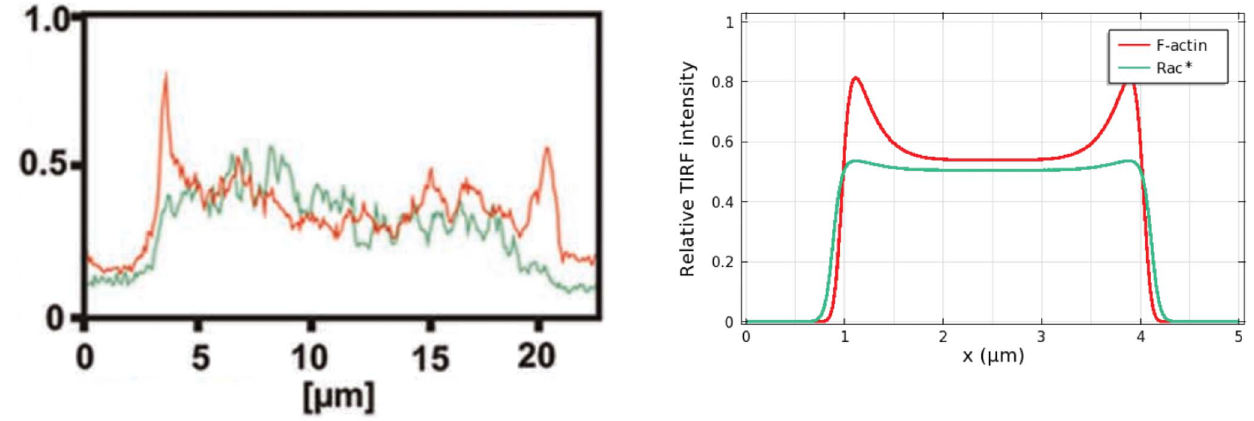
Figure 14. Relative localization of PIP 3 activity. TIRF images show localization of PIP 3 activity within the region enclosed by actin waves. (Left) Experimentally-observed TIRF image from [20]. (Right) Simulated Rac concentration is used to represent PIP 3 activity.